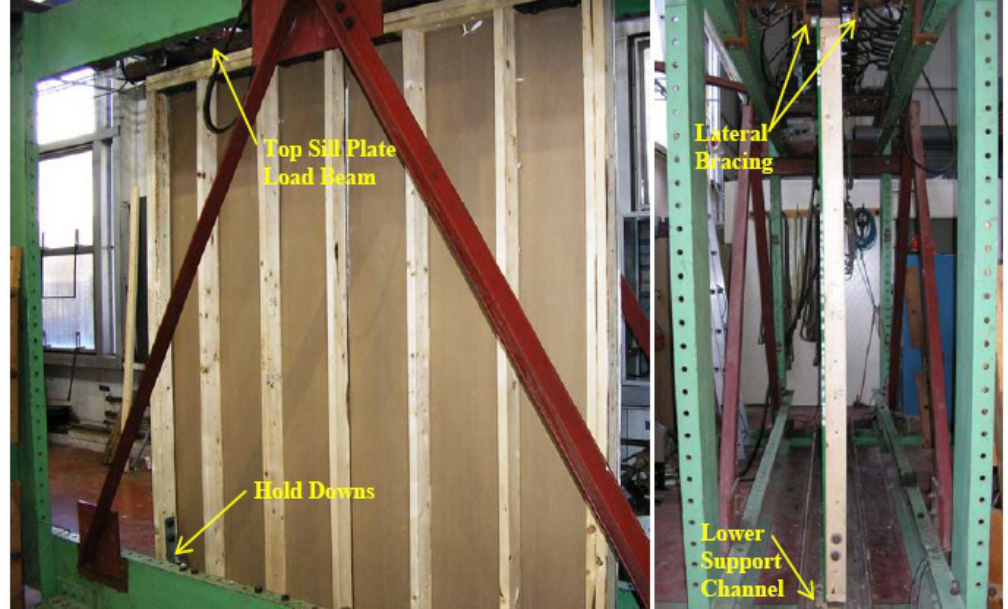
Figure 3. Shearwall test frame with specimen